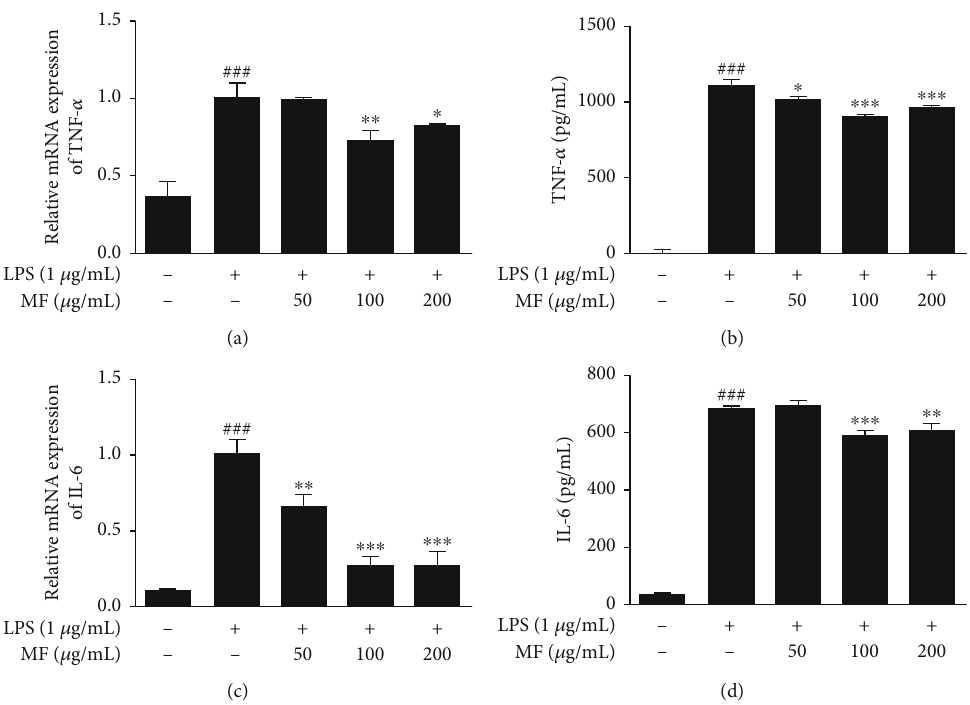
Figure 4: E ff ect of MF on proin fl ammatory cytokines in LPS-stimulated RAW264.7 macrophages. The cells were pretreated with MF for 1h and were then stimulated with LPS (1 μ g/mL) for 6h and 18h to evaluate mRNA expression (a and c) and protein secretion (b and d). The data are presented as mean ± SD . ### p < 0 : 001 vs. the control group; ∗ p < 0 : 05 , ∗∗ p < 0 : 01 , and ∗∗∗ p < 0 : 001 vs. the LPS-treated